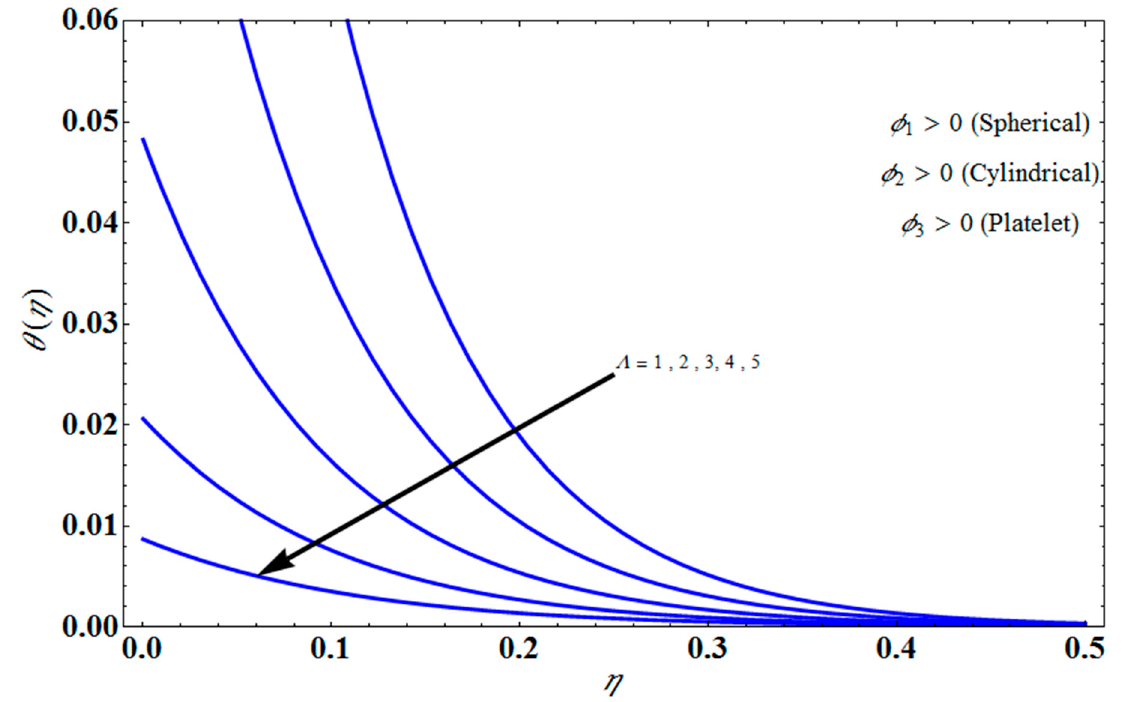
( ) θ η ( ) θ η η η on for different values of on for different values of